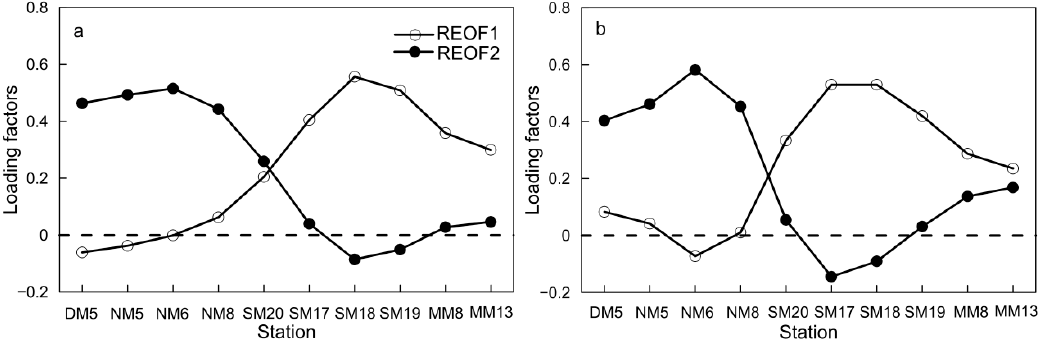
Figure 6. REOFs of DO. ( a ) Surface; ( b ) bottom.